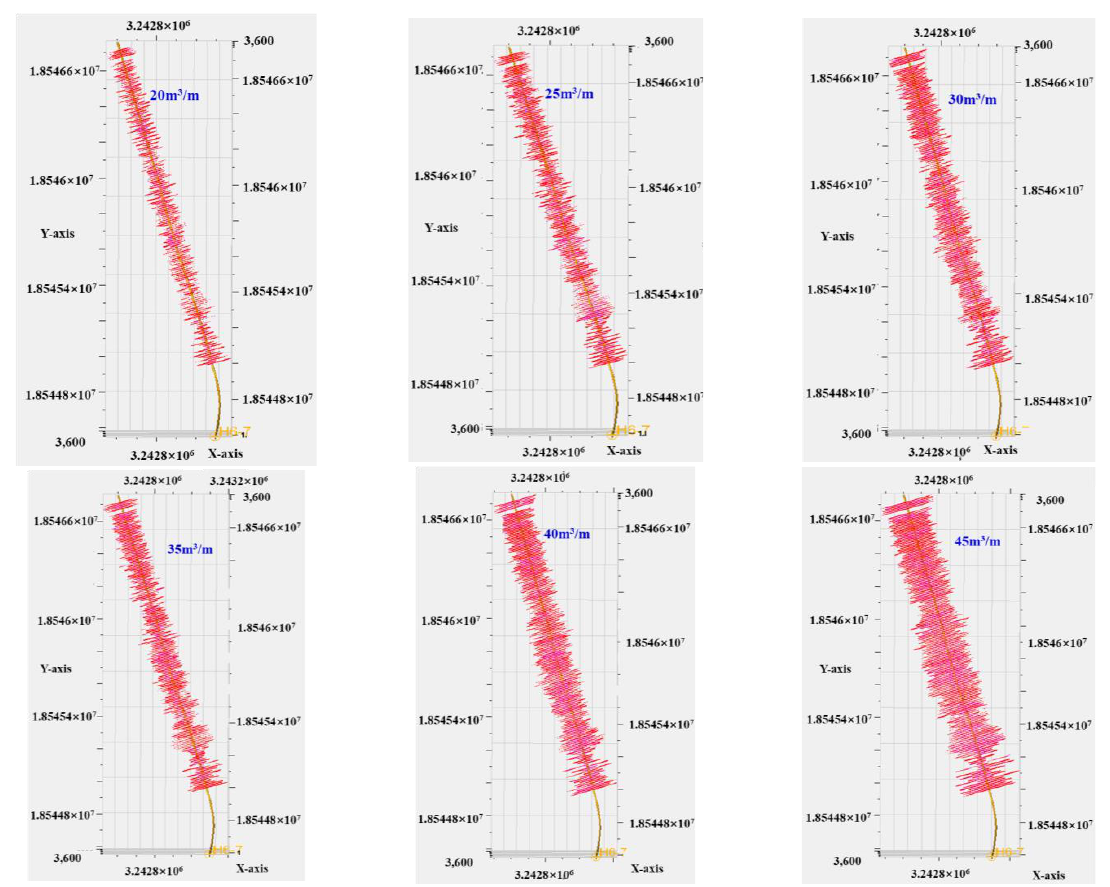
Figure 7. Fracture modification under the different well volume of fracturing fluids.